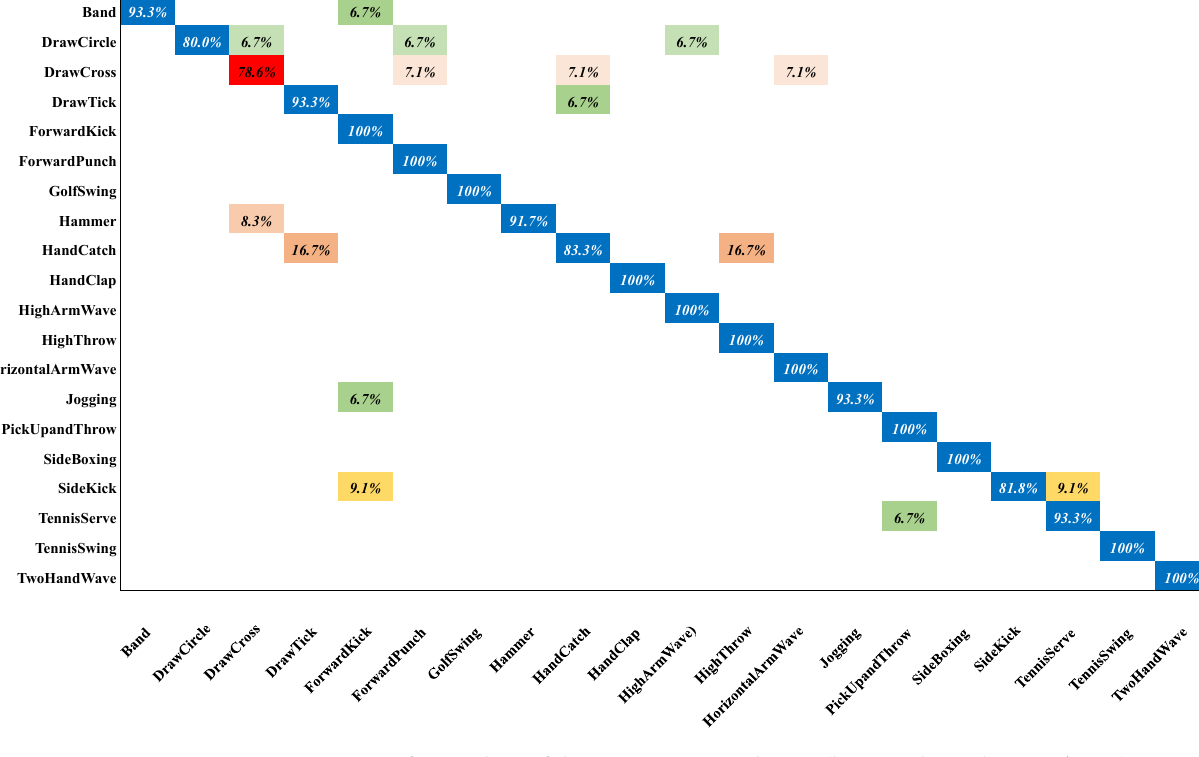
Figure 9. Confusion chart of the MSR-Action3D dataset (best results with SSIM, k = 24).